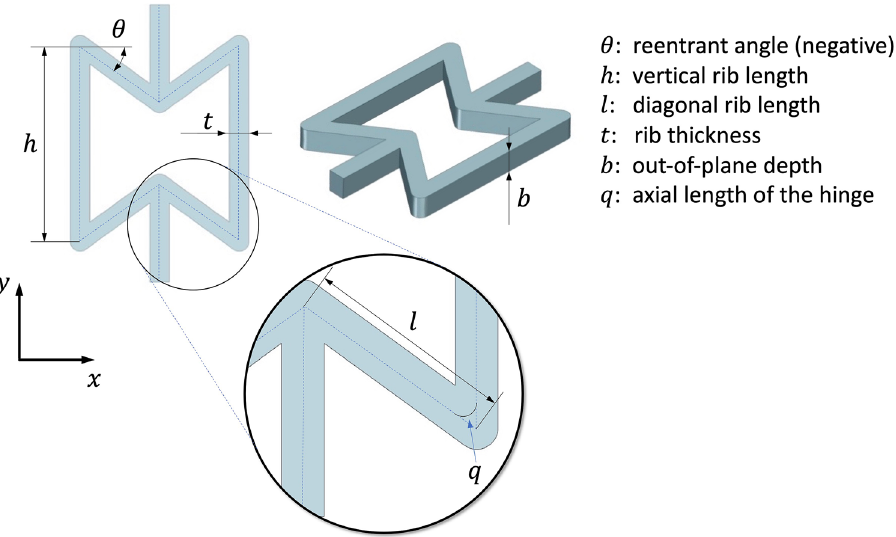
Figure 3. The reentrant honeycomb design and its main geometrical